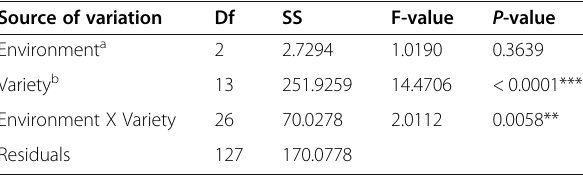
Table 3 Two-way ANOVA on the SSST result (damage score) of NILs responses to multiple factors Source of variation Df SS